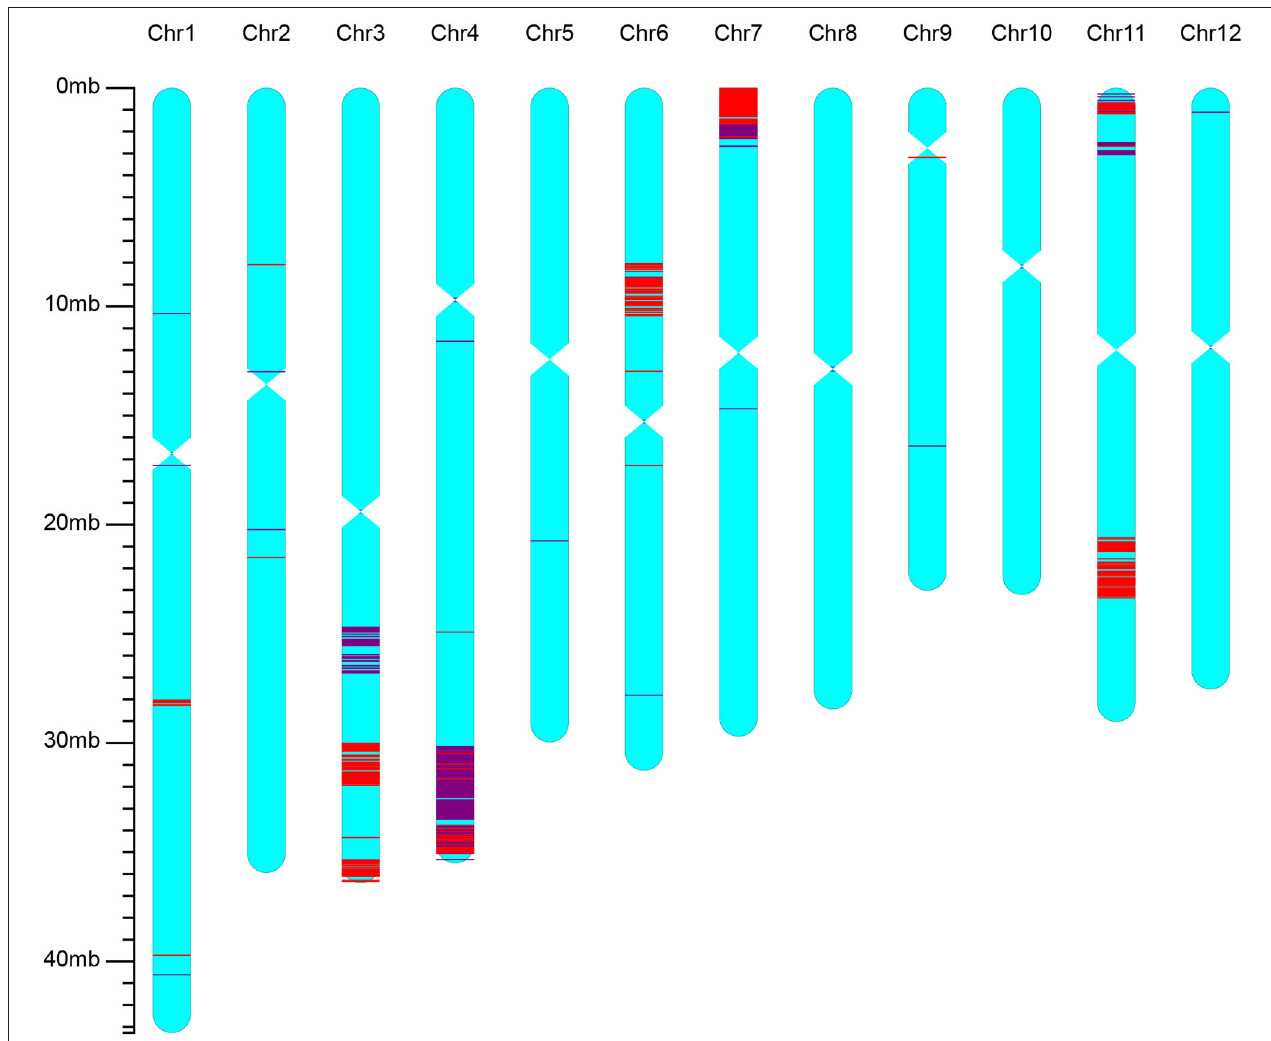
FIGURE 2 | Genetic background of the iR900 line containing genes Xa23 + Pi9 revealed by using the rice 56K SNP chip. The red lines indicate the SNP loci with homozygous genotypes of the donor parent; the purple lines indicate the SNP loci with heterozygous genotypes.